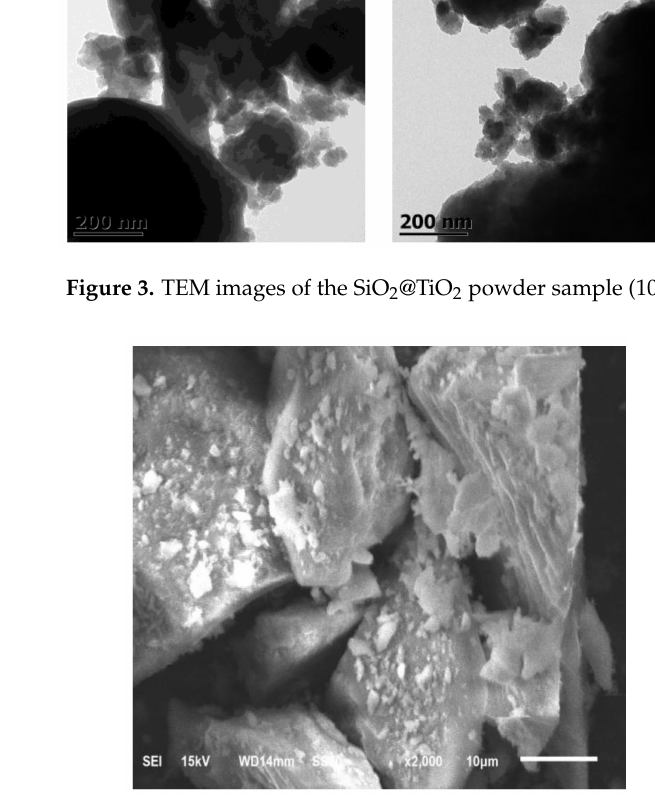
Figure 4. SEM micrographs of the SiO 2 @TiO 2 coating in a power sample.